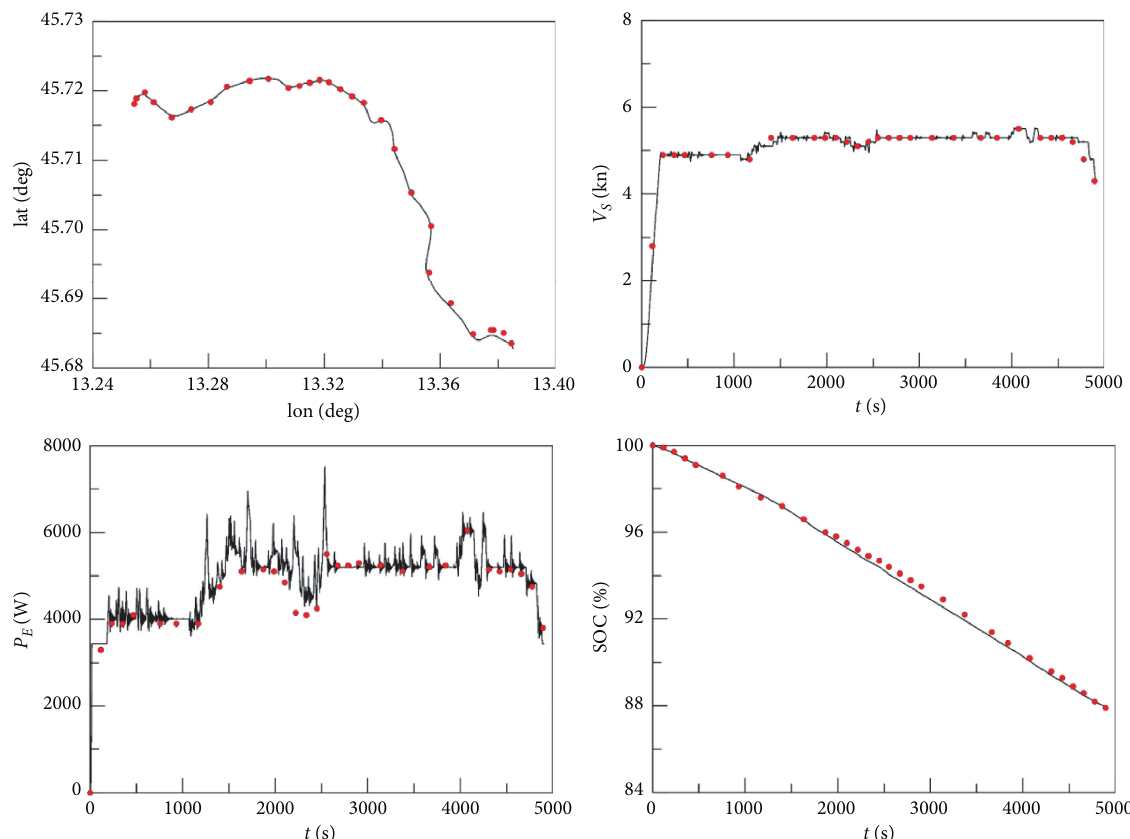
Figure 12: Comparison between measured and simulated data for the Grado-Porto Buso route.